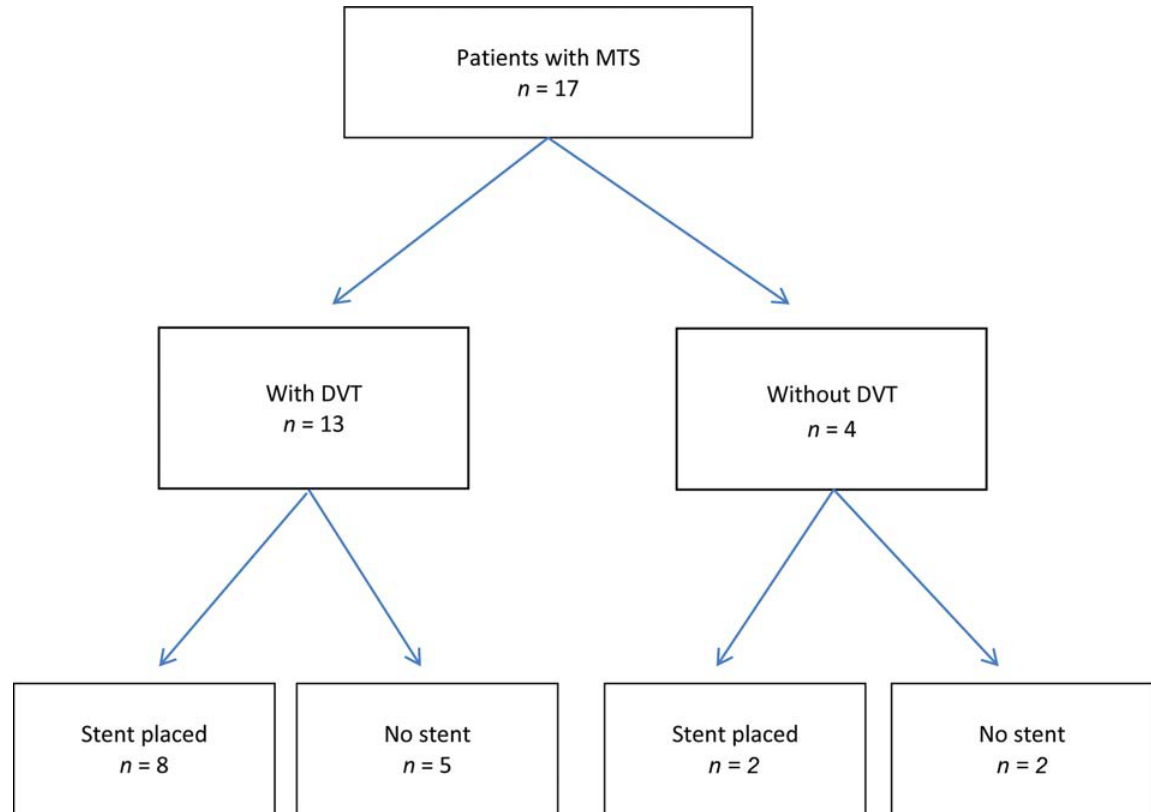
Fig. 1 Summary of patients with May – Thurner